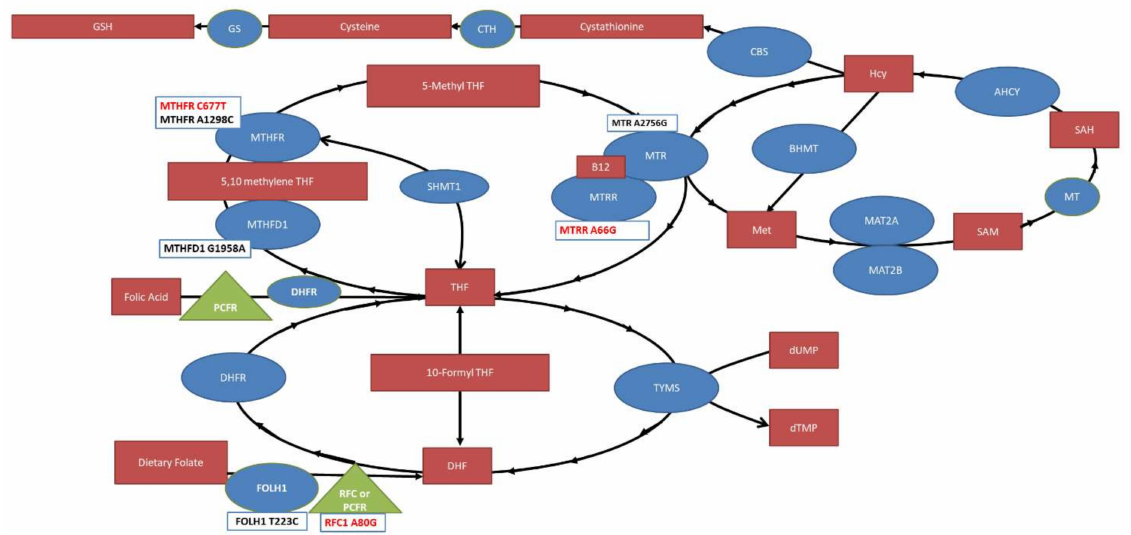
Figure 6. The folate pathway with significant compounds (red boxes), enzymes (blue circles) and transporters (green triangles) outlined. Single nucleotide polymorphisms studied in this meta-analysis are provided in boxes below the enzymes and transporters with the ones found to be significantly associated with NTD risk highlighted in red. MTHFR: Methylenetetrahy- drofolate reductase; MTHFD: Methylenetetrahydrofolate dehydrogenase; MTR: Methionine syn- thase; MTRR: Methionine synthase reductase; THF: Tetrahydrofolate; TYMS: thymidylate synthase; DHFR: Dihydrofolate Reductase; DHF: Dihydrofolate; RFC: Reduced Folate Carrier; FOLH1: Fo- late Hydrolase 1; SHMT1: Serine Hydroxymethyltransferase; BHMT: Betaine—homocysteine S- methyltransferase; SAH: S-adenosylhomocysteine; SAM, S-adenosylmethionine; AHCY, S-adeonsyl- L-homocysteine hydrolase; MAT, methionine adenosyltransferase; Hcy: Homocysteine; CBS: